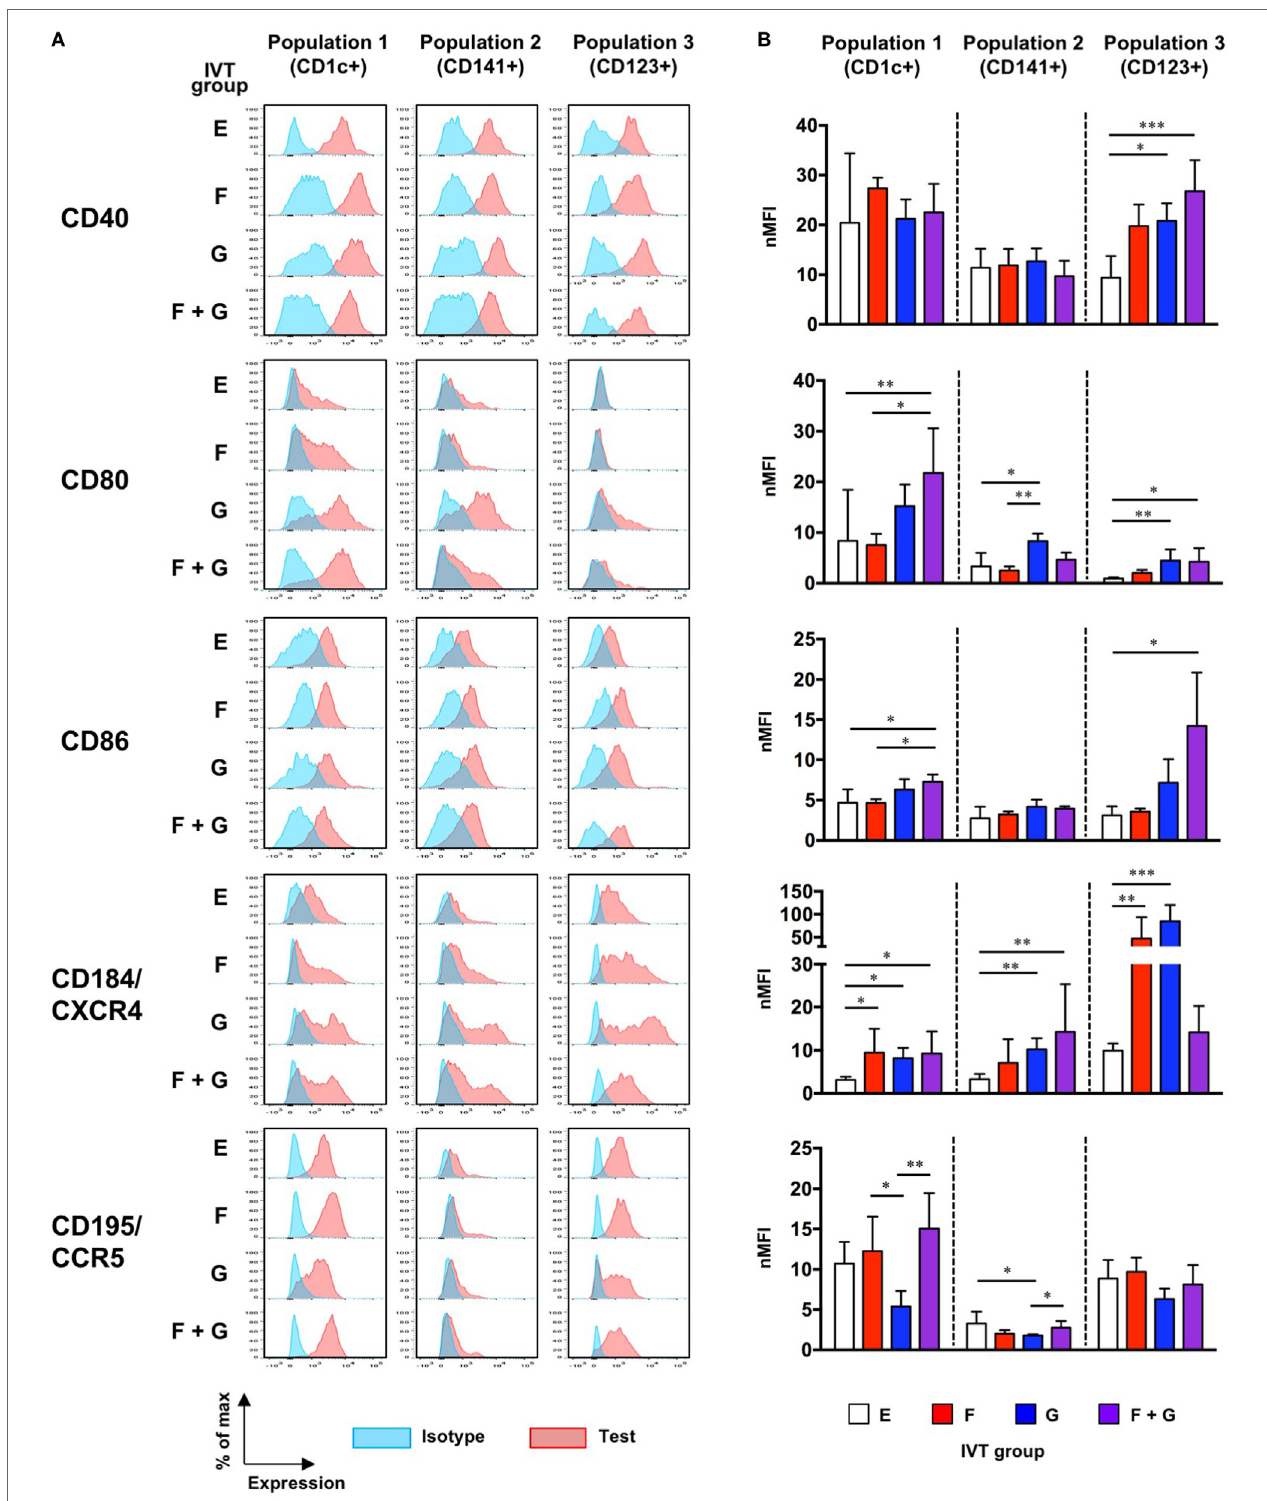
FigUre 7 | Maturation status of putative human dendritic cell populations in hNOJ mice following in vivo transfection (IVT). Splenocytes from each IVT group were subjected to flow cytometric analysis for maturation-associated markers. (a) Representative histograms of test marker and isotype staining. (b) Comparison of the normalized mean fluorescence intensity among IVT groups. Data are expressed as the mean ± SD (Group E: n = 9, Group F: n = 6, Group G: n = 5, Group F + G: n = 6). Significant differences (* P < 0.05, ** P < 0.01, *** P < 0.001) were determined by the Kruskal–Wallis test followed by the Dunn’s multiple comparisons test.